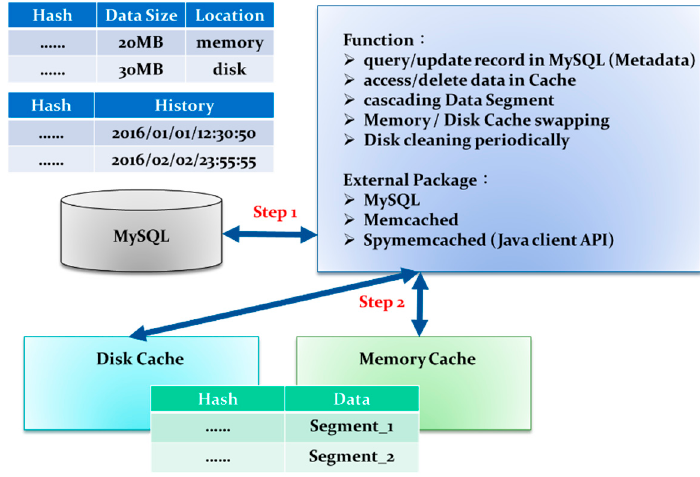
Figure 4. Creating table and storing the information in the metastore.